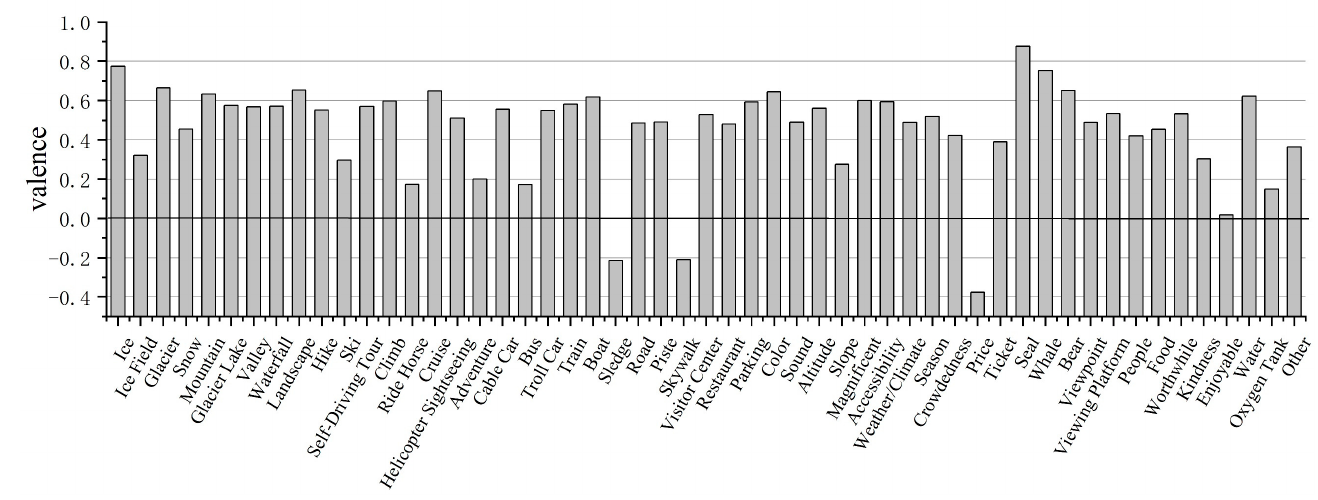
Figure 5. Attribute valence results.